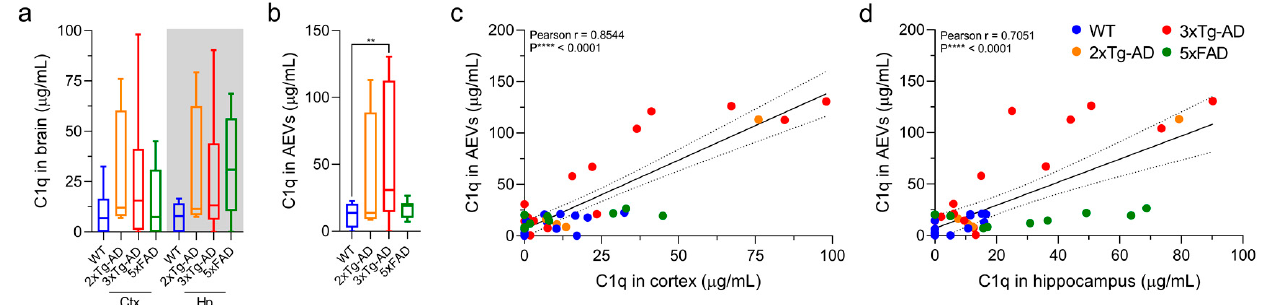
Figure 4. Brain and AEV C1q are increased in 3xTg-AD mice and positively correlate across mouse groups. ( a , b ) Box plots displaying complement C1q ( a , b ) protein levels in brains and AEVs of different AD mouse models and WT mice as measured by mouse C1q ELISA. Results in ( b ) show significantly increased levels of C1q in AEVs of 3xTg-AD mice compared to WT controls (one-way ANOVA; ** p = 0.0049). ( c , d ) ELISA C1q levels in AEVs in relation to Ctx and Hp show statistically significant positive correlations as indicated by the Pearson correlation coefficient shown in each graph. All mice indicated in the methods section were included in the analysis. Several outliers were identified and removed based on the ROUT test (hippocampal C1q: 2 WT values). Matched samples from subjects providing outlier values were removed for the correlation